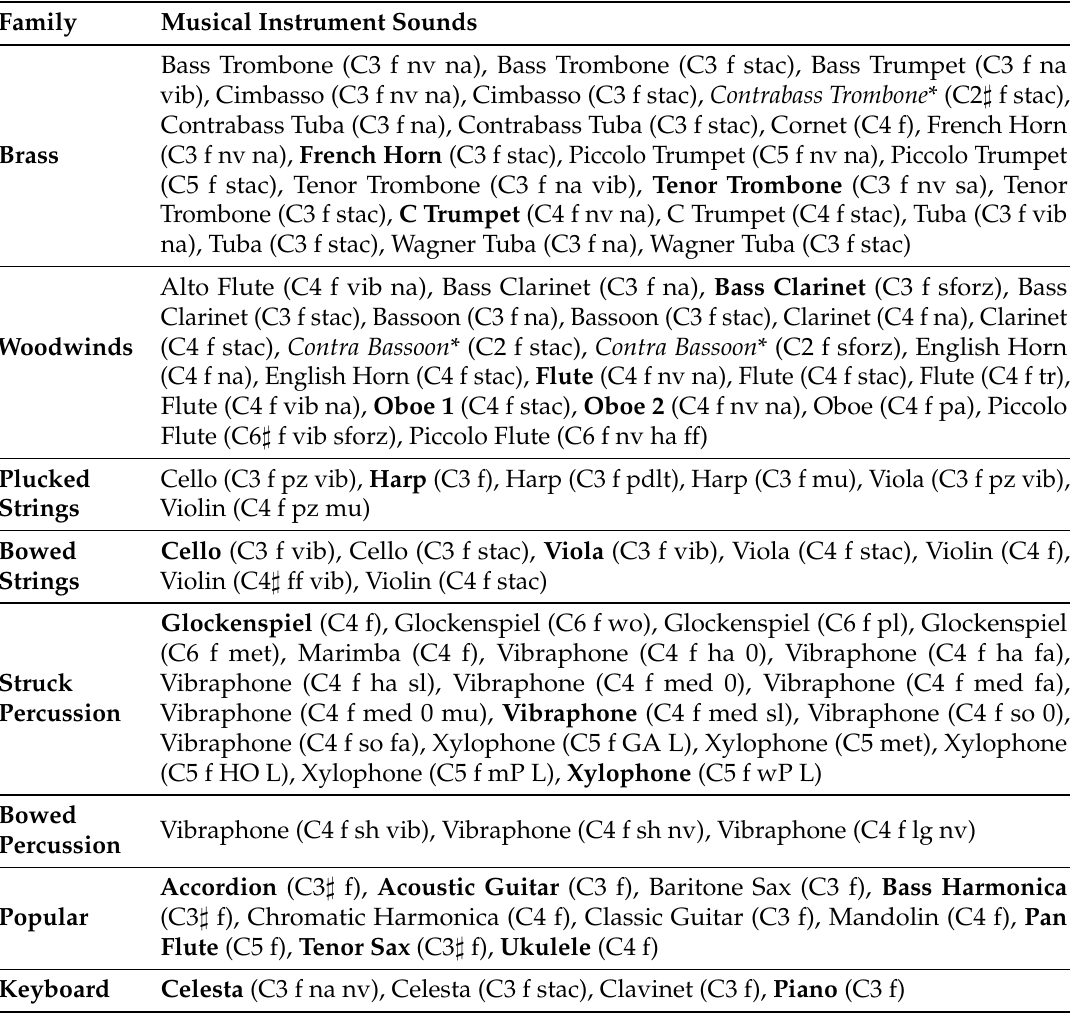
Table 1. Musical instrument sounds used in all experiments. See text in Section 4.1 for a description of the terms in brackets. Sounds in bold were used in the listening test described in Section 6. The quasi-harmonic model (QHM) failed for the sounds in italics marked